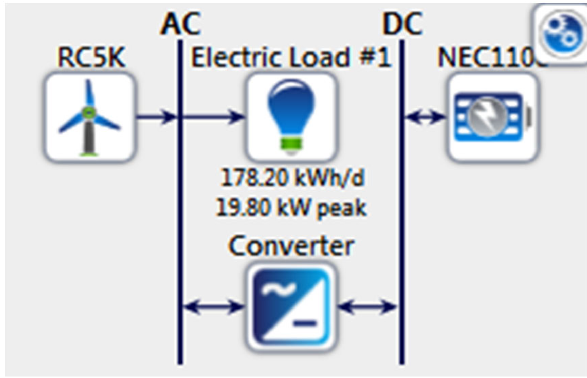
Figure 5. Schematic diagram for the system.